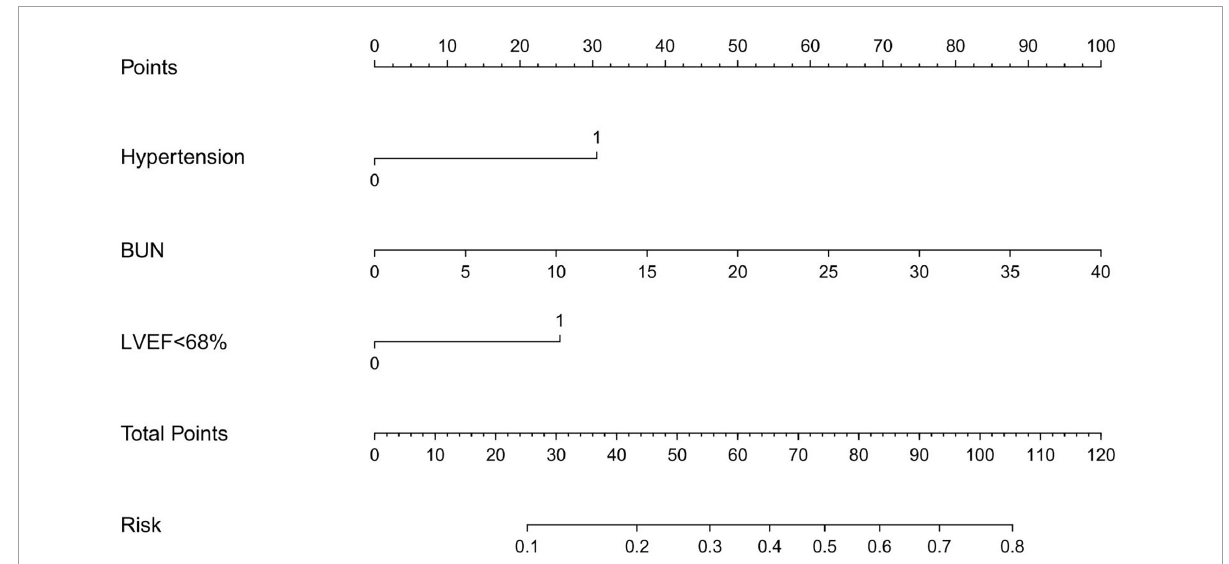
FIGURE3 Nomogram for predicting myocardial injury in patients with acute upper gastrointestinal bleeding. BUN, blood urea nitrogen; LVEF, left ventricular ejection fraction.